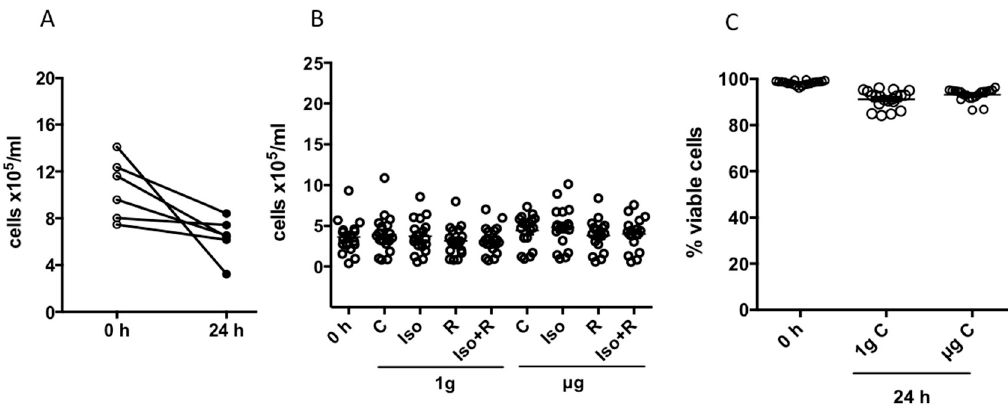
Figure 1. Cell recovery and cell viability after 24 h incubation in rotating-wall vessels (RWVs): ( A ) Change in the initial cell concentration with incubation time at a rotation speed of 10 rpm (6 independent experiments); ( B ) cell recovery of nontreated and treated cells over experimental conditions before and after 24 h incubation in RWVs rotating at 8.5 rpm (18 independent experiments); and ( C ) the percentage of live nontreated cells that remained alive after 24 h incubation rotating at a speed of 8.5 rpm (20 independent experiments).